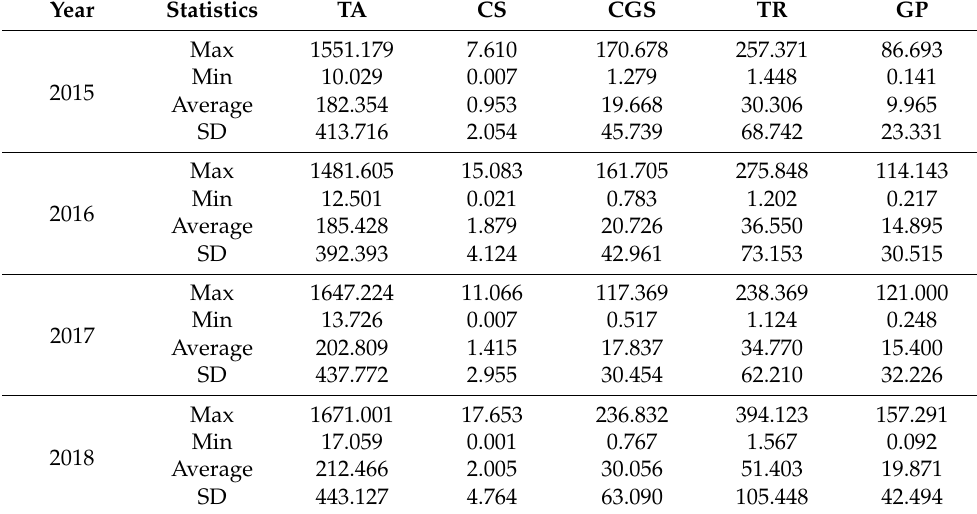
Table 6. Summary of statistics for the period from 2015 to 2018.